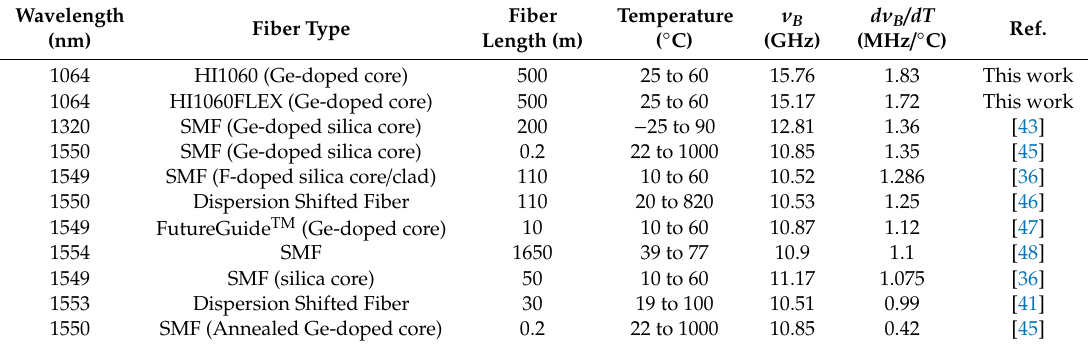
Table 1. Comparison of temperature-dependent SBS characteristics.